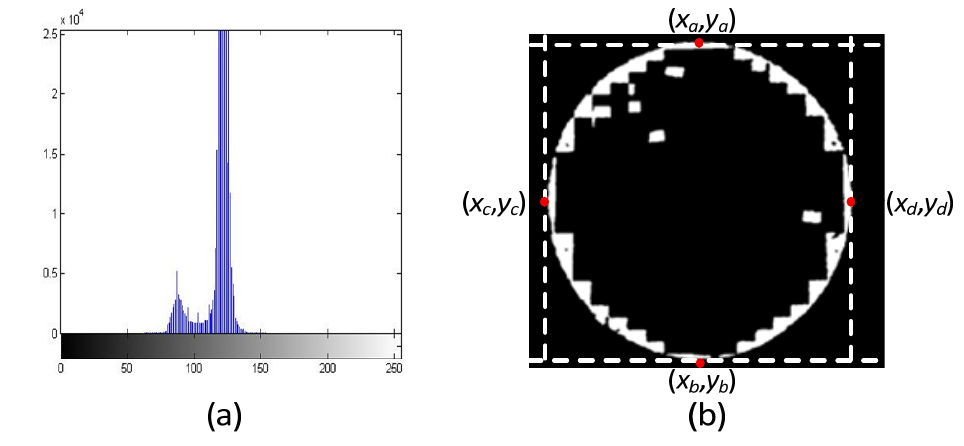
Figure 7. ( a ) Histogram of the Cb component; ( b ) the image of the resident die